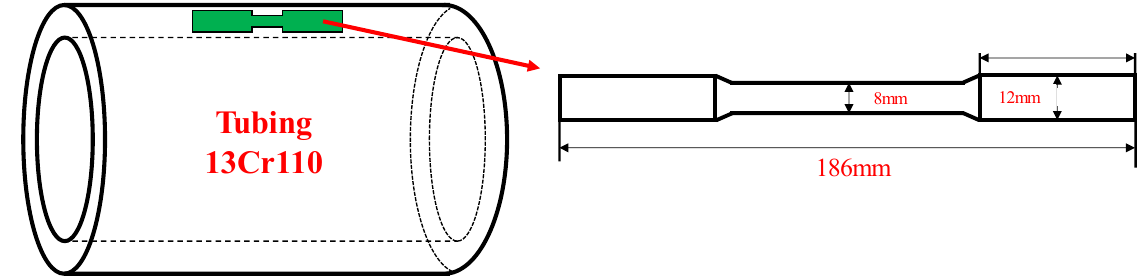
Figure 2. The schematic diagrams of specimen used for tensile test.